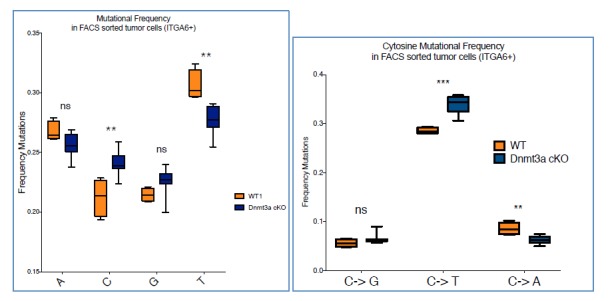
DOI:
http://dx.doi.org/10.7554/eLife.21697.037